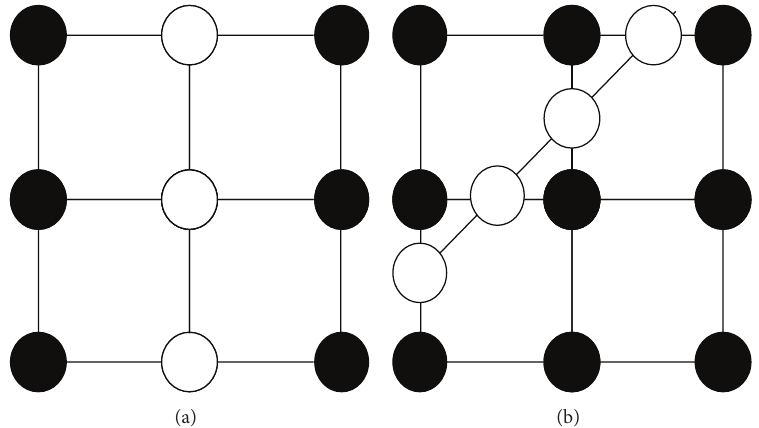
Figure 2: Division methods. Active nodes are indicated with closed circles and collector nodes indicated with open circles. Lines indicate links. (a) Equal division and (b) unequal division for collector